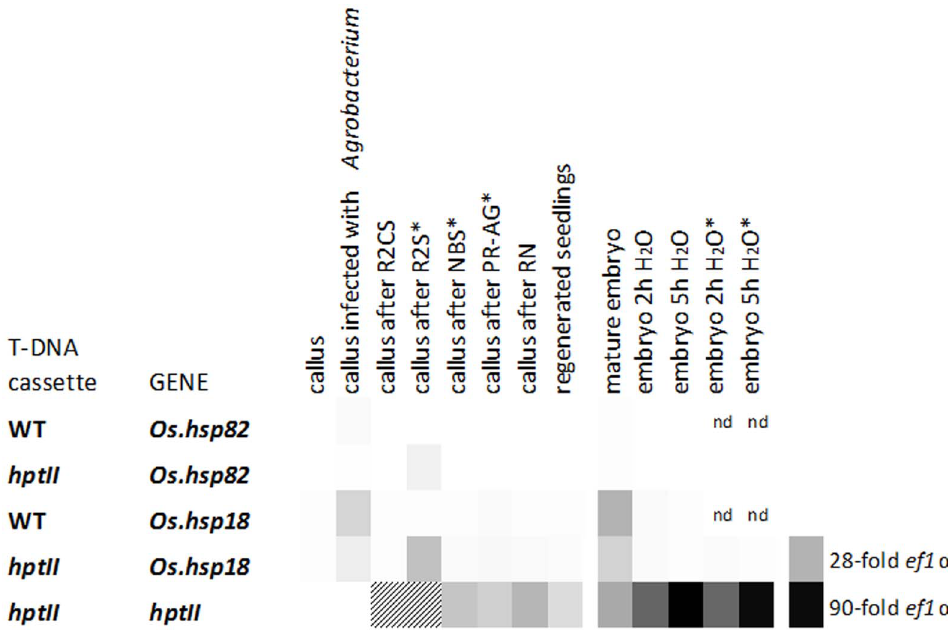
Figure 3. mRNA expression profiles of Os.hsp18 , Os.hsp82 and the hptII transgene, driven by the CaMV 35S promoter, in rice var. Senia. Different stages during transformation with A. tumefaciens , either carrying pCAMBIA1300 ( hptII ) or no T-DNA (WT), and expression in mature and imbibed embryos, are shown. The following stages of callus are shown: 6 weeks after induction of embryogenic callus; immediately after 15 min infection with A. tumefaciens ; after a 3-day incubation in R2CS medium; after a 2-week incubation in R2S selection medium; 3 weeks after transfer to NBS selection medium; after an 8 to 10-day incubation in PR-AG selection medium; 3–4 weeks after induction of regeneration in RN medium; and two weeks after seedling culture in P medium. Embryos extracted from mature seeds, either before or after imbibition in water for two or five hours, were also analyzed. When the hptII DNA cassette was transformed, transgenic cells were selected using hygromycin (asterisk). Three biological replicates, each of five calluses, with two experimental replicates, were analyzed at each stage. The ef1 a reference gene (M values , 0.5 in these samples) was used for normalization. Dark to light color scale represents high to low expression level. All values were in the 90 to 0.01-fold range. nd: not determined. Striped: underestimated values due to callus samples containing a mixture of transgenic and non-transgenic